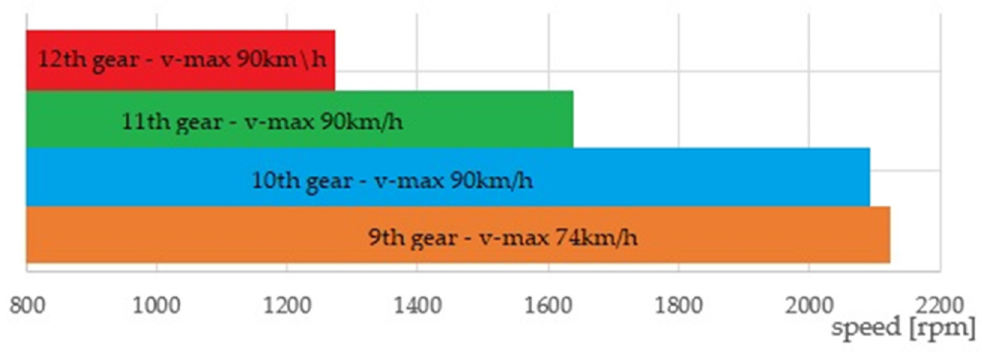
Figure 7. Graph of the coverage of the RPM engine operating range for selected gears (authors’ source) .